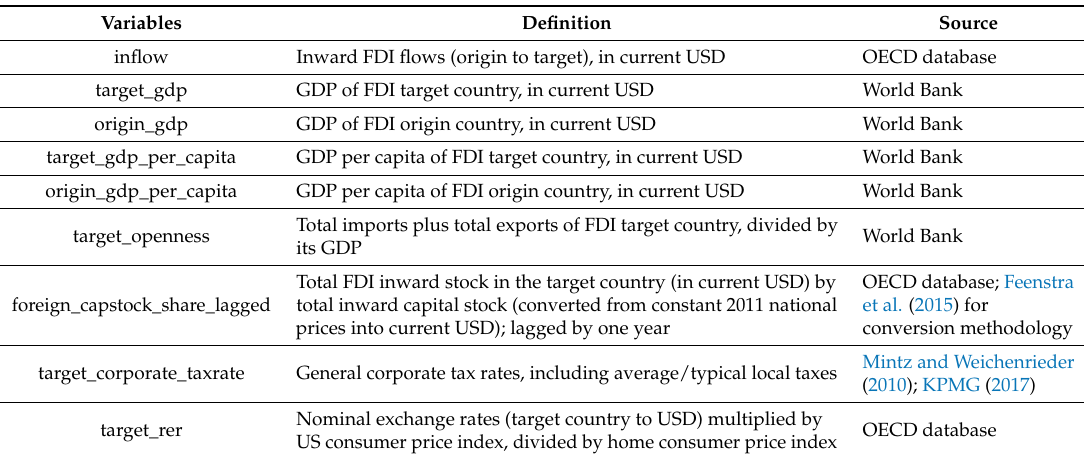
Table 2. List of